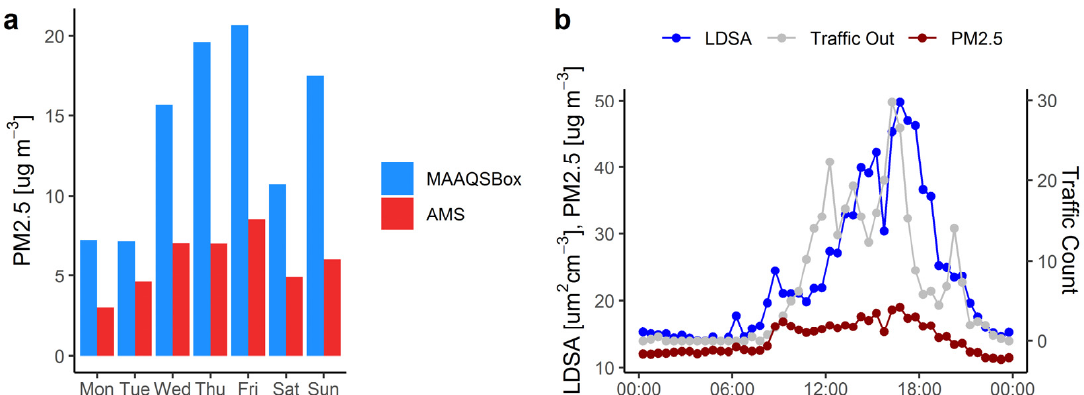
9 of 16 Figure 3. ( a ) Daily CO 2 Concentrations. ( b ) daily variation of entry, exit, and total traffic, and CO 2 concentration with time of day, weekday 30 min averages. ( c ) Daily average CO concentrations measured in the garage by the MAAQSBox and ambient levels measured at the nearest AMS and ( d ) daily variation of CO and CO 2 concentration and exit traffic, weekday 30 min averages. ( e ) Daily average NO concentrations measured in the garage by the MAAQSBox and ambient levels meas ‐ ured at the nearest AMS and ( f ) daily variation of NO and CO concentration and exit traffic, week ‐ day 30 min averages. ( g ) Daily average NO 2 concentrations measured in the garage by the MAAQSBox and ambient levels measured at the nearest AMS and ( h ) daily variation of NO 2 and NO concentration and exit traffic, weekday 30 min averages. ( i ) Daily average O 3 concen ‐ trations measured in the garage by the MAAQSBox and ambient levels measured at the nearest AMS and ( j ) daily variation of O 3 and NOx concentration and exit traffic, weekday 30 min averages. Other research on PM2.5 showed 1.54 times higher concentration in an underground garage compared to outdoor concentrations [46,58]. Concentrations of 43 to 60 μ g m − 3 were reported in a garage while at the same time in the street they ranged 23 to 27 μ g m − 3 [14]. In a study of 8 naturally ventilated residential underground parking garages daily average PM2.5 concentrations ranging from 50 to 200 μ g m − 3 were reported by Liu [59]. PM2.5 8 h daily average concentrations in an underground parking facility in India rang ‐ ing from about 60 to 240 μ g m − 3 were measured by Samal [13]. LDSA is a measure of ultrafine particles which are less stable and more impacted by local conditions than PM2.5. The LDSA concentration follows exit traffic, with a peak value of 49.9 μ m 2 /cm 3 between 4:30 and 5:00 p.m. The overall range of 1 h average LDSA concentrations is from 5.8 to 98.5 μ m 2 /cm 3 in the garage. Kuuluvainen [60] have reported outdoor measurements of LDSA in Finland, with average background and near road val ‐ ues of 12 and 94 μ m 2 /cm 3 , respectively. There are no ambient standards for LDSA. Particle emissions from vehicles are not only from the engine but also from tires, brakes, and the vehicle chassis [54]. These tire and brake particles contain copper, barium, iron, and anti ‐